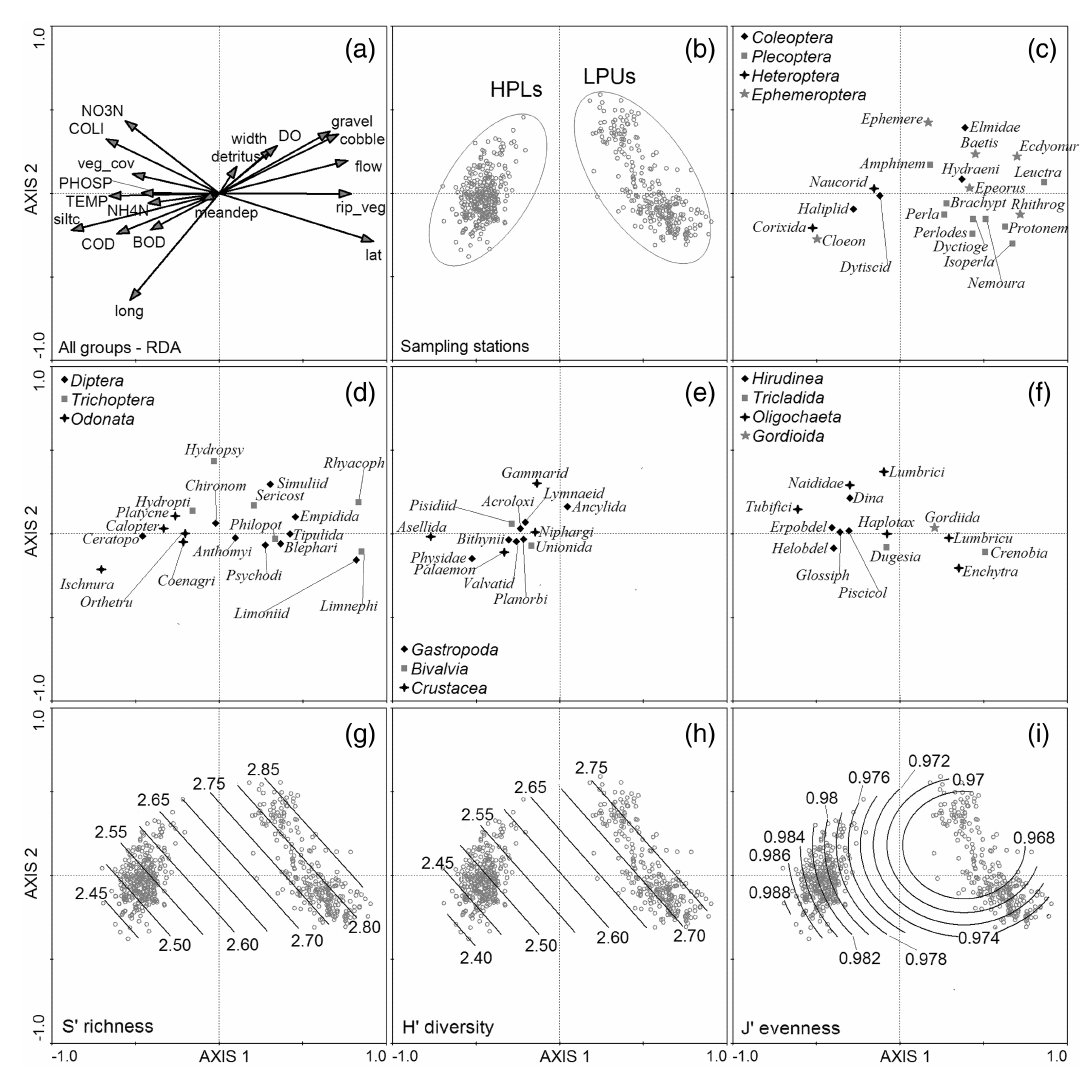
Figure 1. RDA ordination graphs: (a) environmental gradients, (b) sampling stations, (a–f) taxa in parts, (g) richness S (cid:48) , (h) diversity H (cid:48) and (i) evenness J (cid:48) (for abbreviations, see Tables S1 and S2).